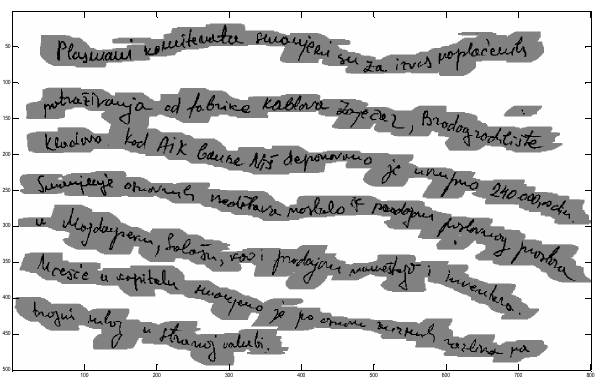
Figure 10. Algorithm based on anisotropic Gaussian kernel applied to the text